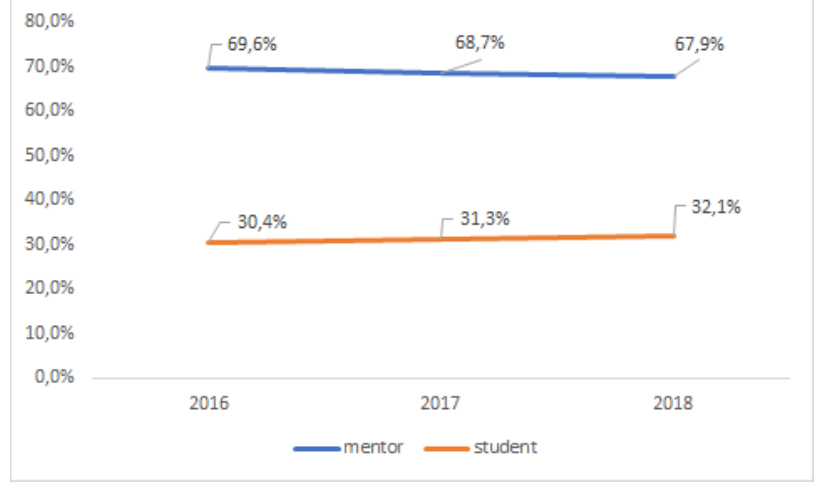
Figure 5. Developer sorted by type in GSoC from 2016 to 2018